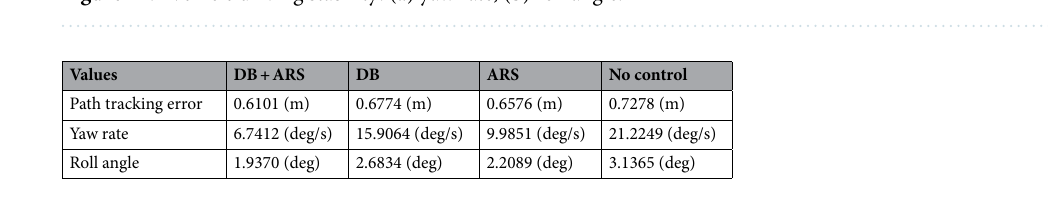
Table 3. RMS values of different control